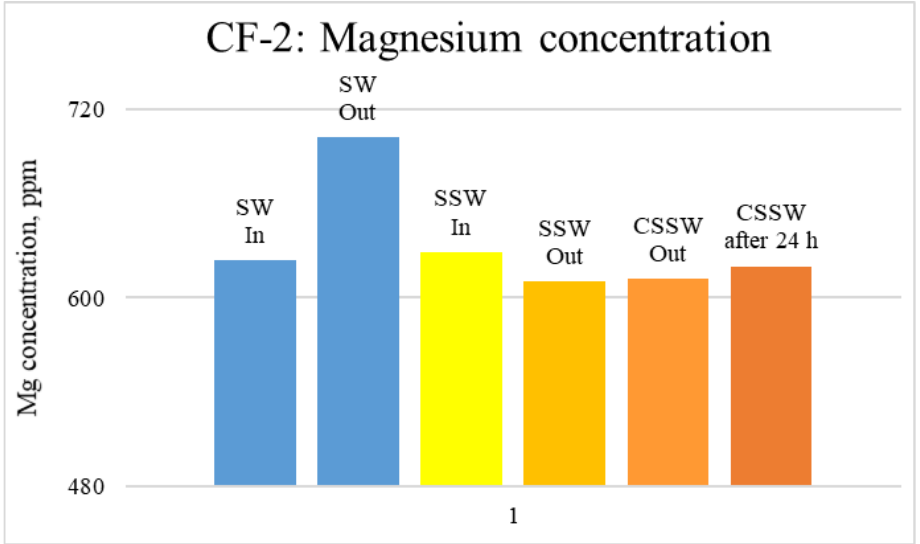
Figure 16. ICP analysis of CF-2 brines: Magnesium concentration.